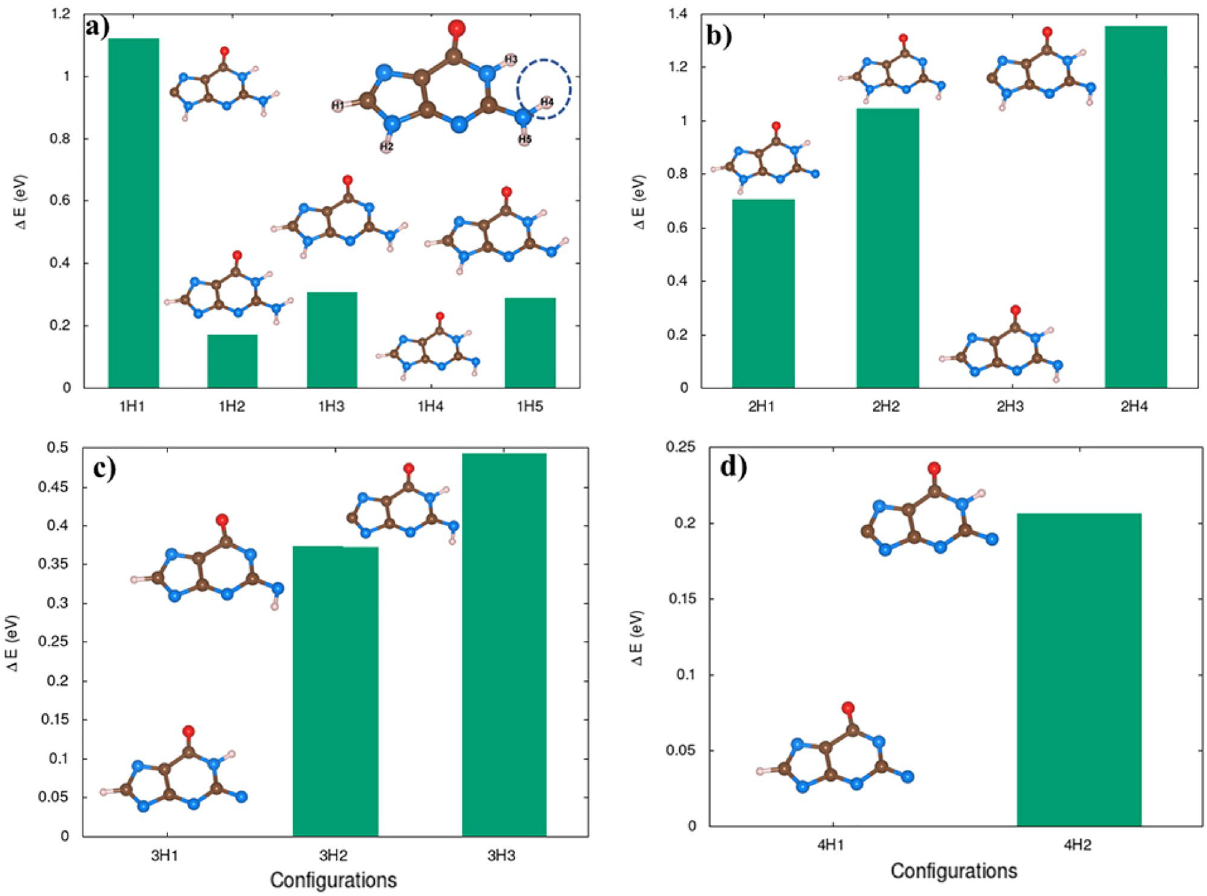
Figure 9. The effect of hydrogen removal in Guanine molecule. Notation—1H1 refers to one H removed the first configuration, 1H5 refers to 1H removed and is the fifth configuration. Similarly, 2H1: 2H atom